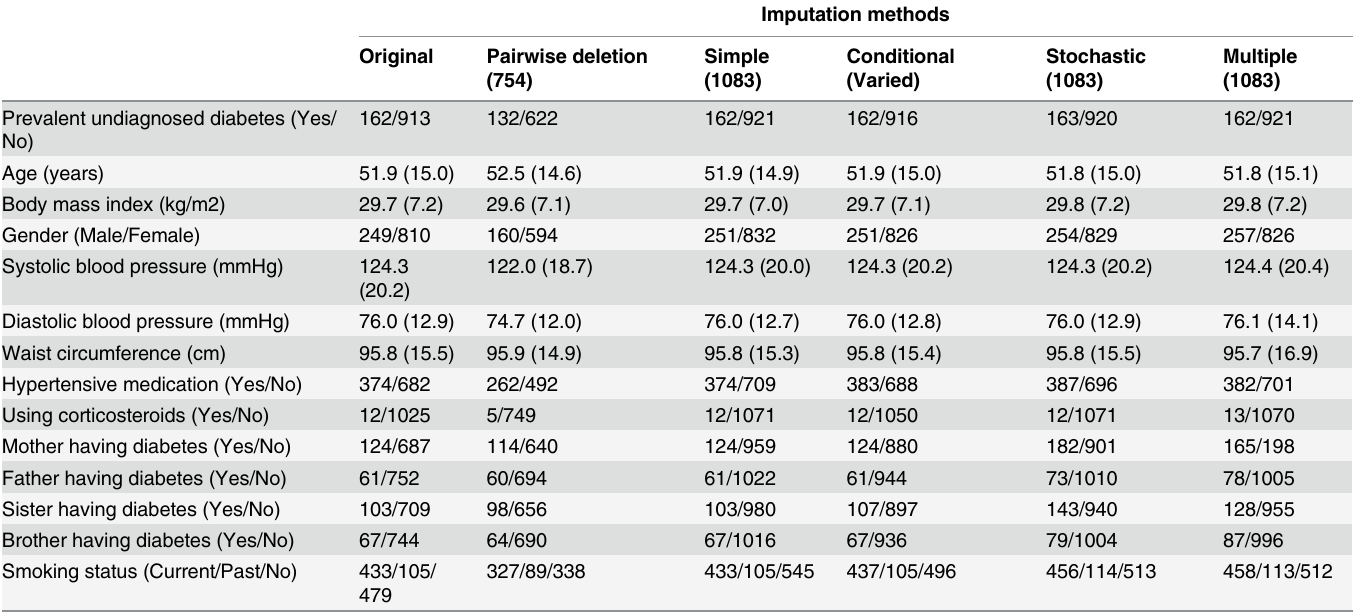
Table 3. Characteristics comparison of participants for the original database and five imputation methods.